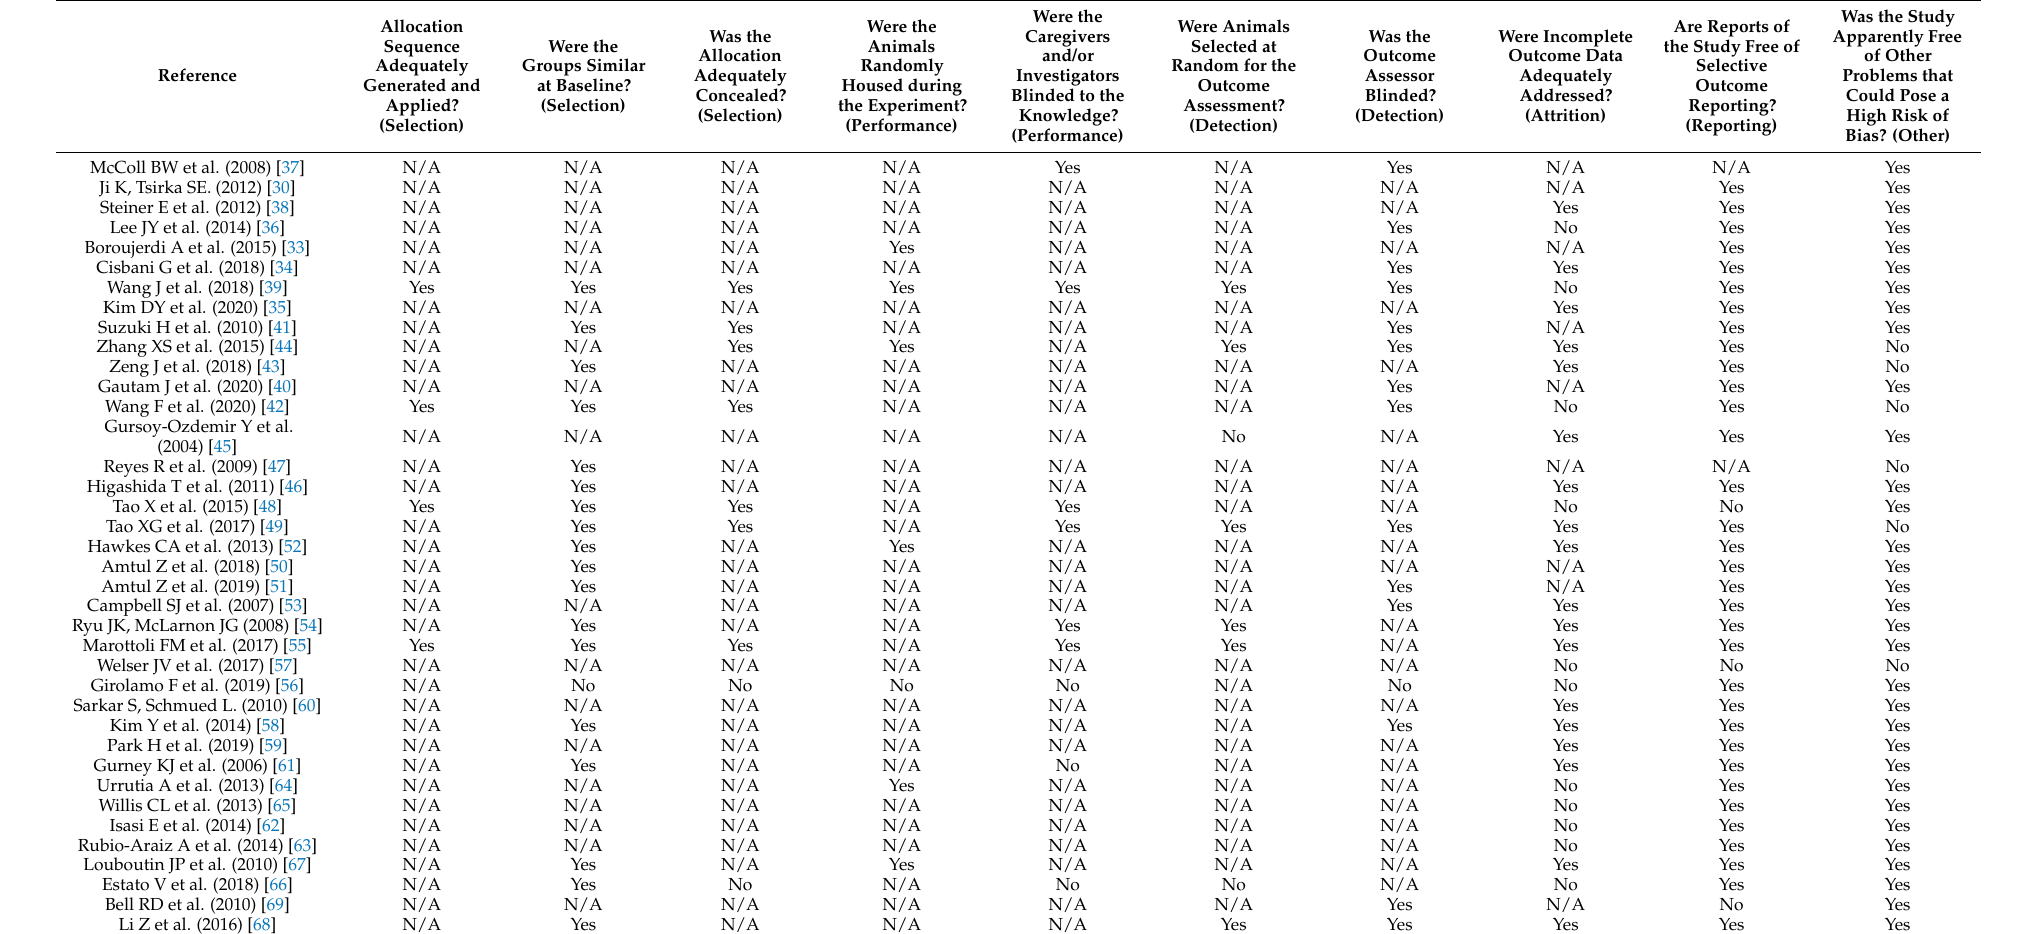
Table 2. Risk of bias